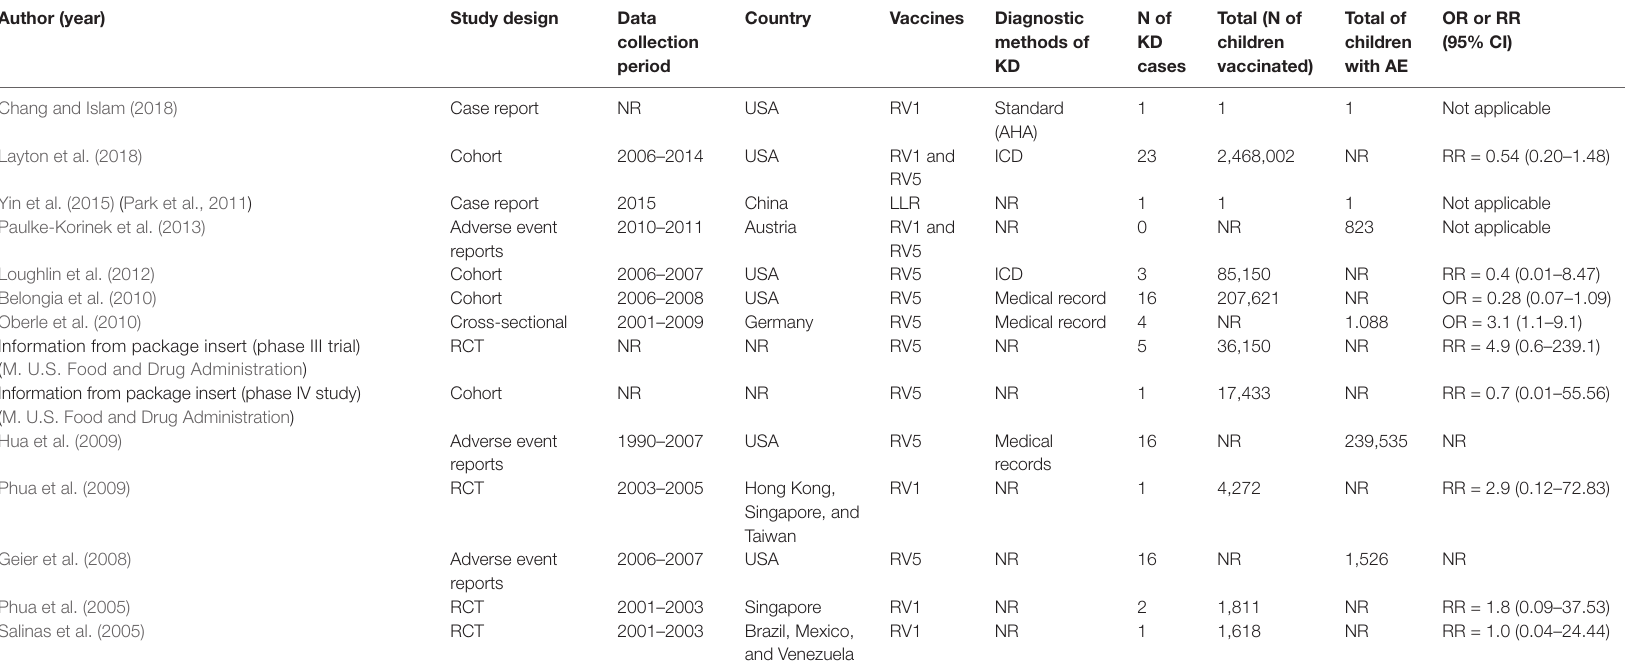
TABLE 1 | Characteristics of the studies and outcomes found in children vaccinated against the